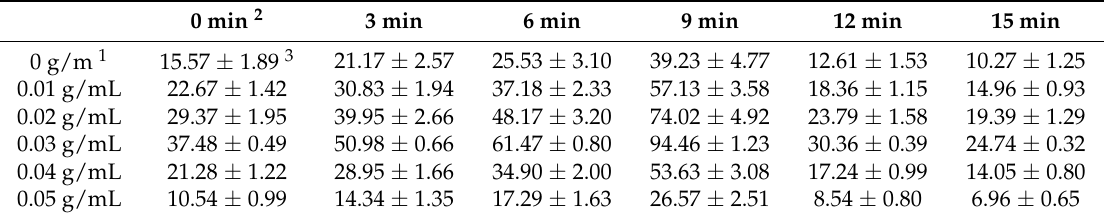
Table 4. Effect of combined changes in pretreatment conditions on egfp